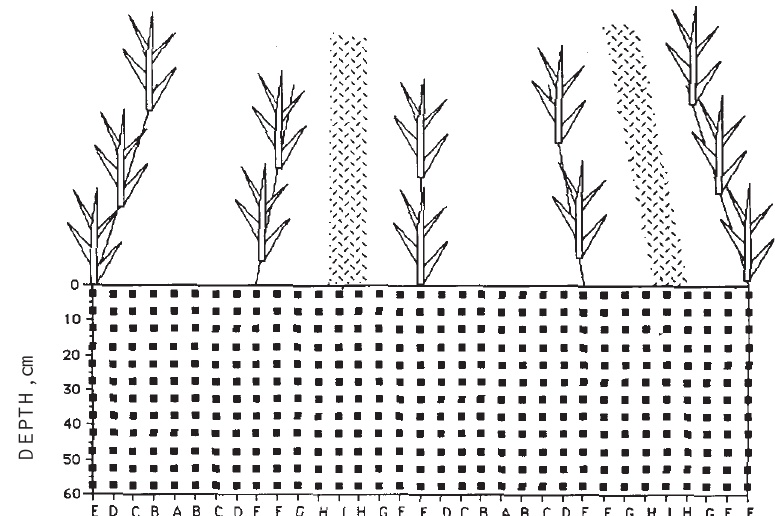
Figure 2. Sampling design: 33 horizontal points 12.5 cm apart and 12 depth increments each 5 cm long. Letters identify sampling points on the transect in relation to distance from the nearest corn row, and to the presence or absence of wheel